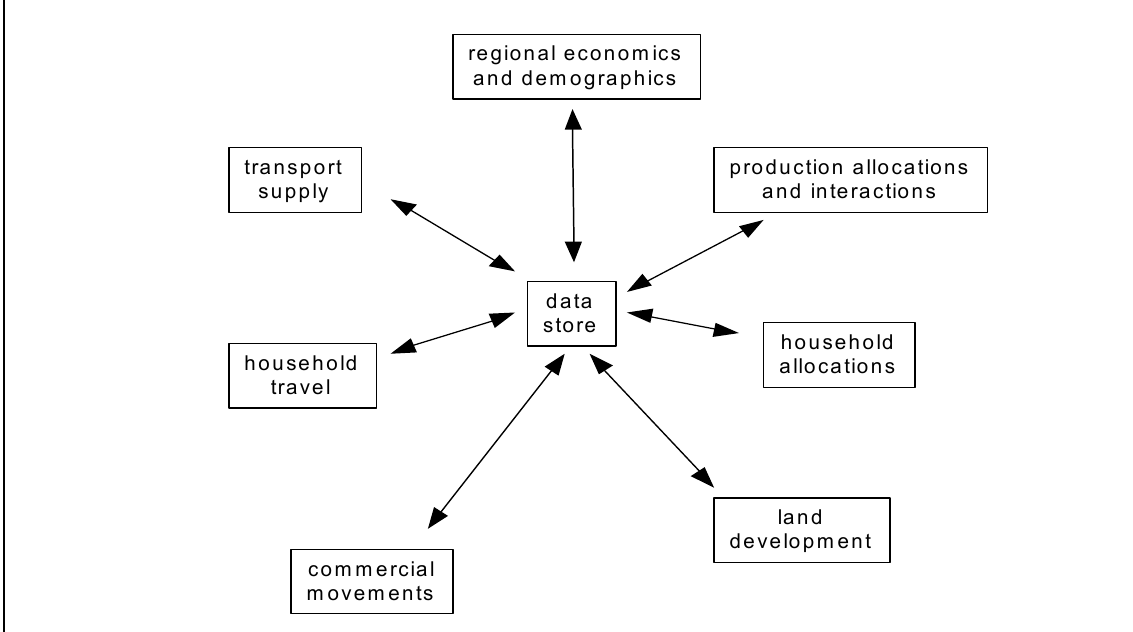
Figure 4: The modules in the model and the flows of information among